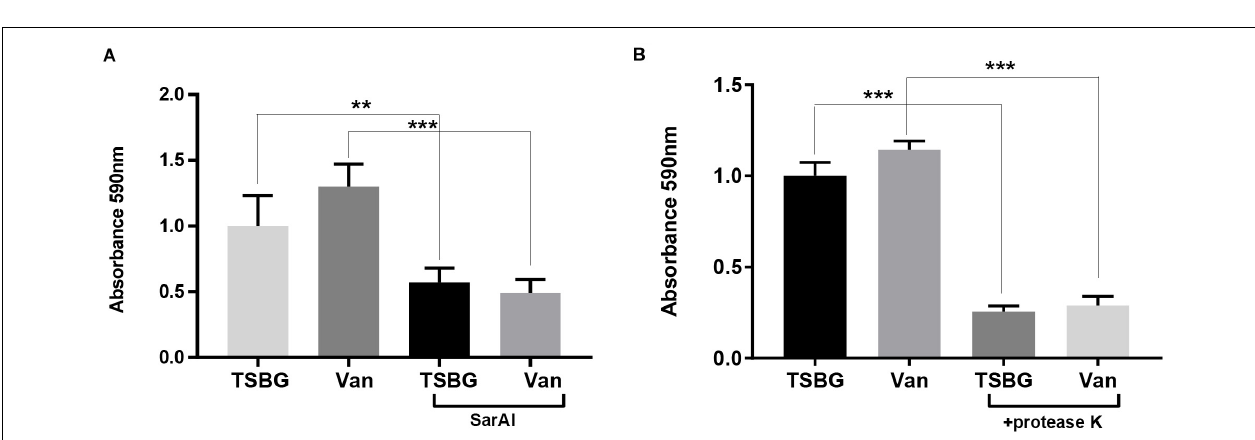
FIGURE 5 | Anti-biofilm function of ZINC00990144 (A) and proteinase K (B) . (A) ZINC00990144 is effective to USA300 biofilm with/without exposure to sub-MIC vancomycin. (B) Sub-MIC vancomycin promotes biofilm formation. Proteinase K (100 µ g/mL) added at the initiation of the experiment inhibited biofilm formation completely, regardless of whether vancomycin is present. Van: sub-MIC vancomycin (0.5 µ g/mL), SarAI: ZINC00990144, TSBG: TSB medium supplied with 0.5% glucose, ** P < 0.01, *** P < 0.001 comparing with corresponding control.